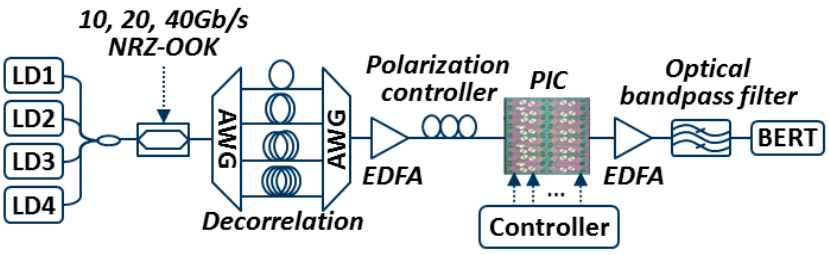
Figure 5. Experimental setup employed to assess the performance of the WDM photonic cross-connect.